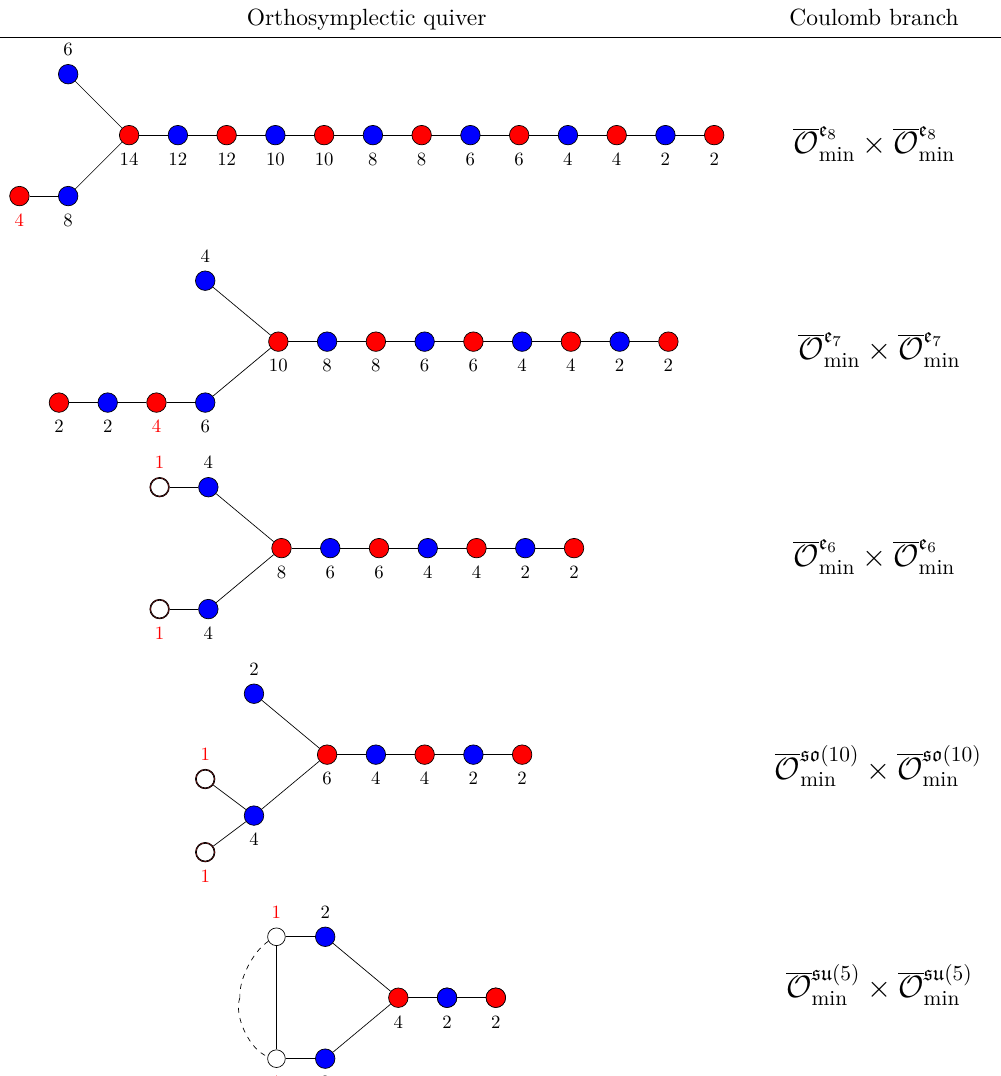
Table 3. The Coulomb branches of orthosymplectic quivers are products of two copies of the minimal nilpotent orbits closures of exceptional algebras e in red represent gauge nodes that are